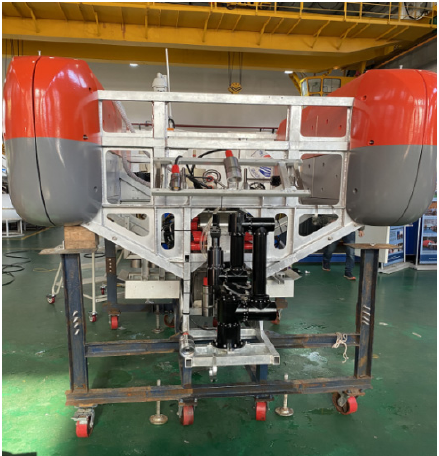
Figure 15. The manipulator installed on the bow of the ARV.